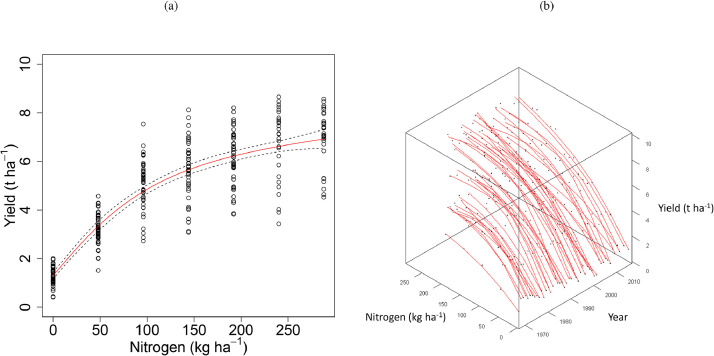
Relationship between winter wheat grain yield (t ha−1 at 85% dry matter) and applied nitrogen (kg N ha−1) from Section 1 (all with PKNaMg) of the Broadbalk Long Term Experiment provided by the LEXP function for the years 1968 to 2016. (a) LEXP function fitted to data (○) for all years combined (Eq. (1)), with parameter (S.E.) values a = 2.402 (0.225), b = −1.261 (0.222), c = 0.00085 (0.0008), r = 0.985(0.003) (fitted curve – red – ±95% Confidence intervals for the curve – dashed). (b) LEXP function fitted to data (•) for each year separately (Eq. (2)), where r = 0.988 (S.E. 0.0009) and estimates of a, b and c varied amongst years. Analyses were conducted on square-root transformed data and the fitted functions back-transformed in the figure.